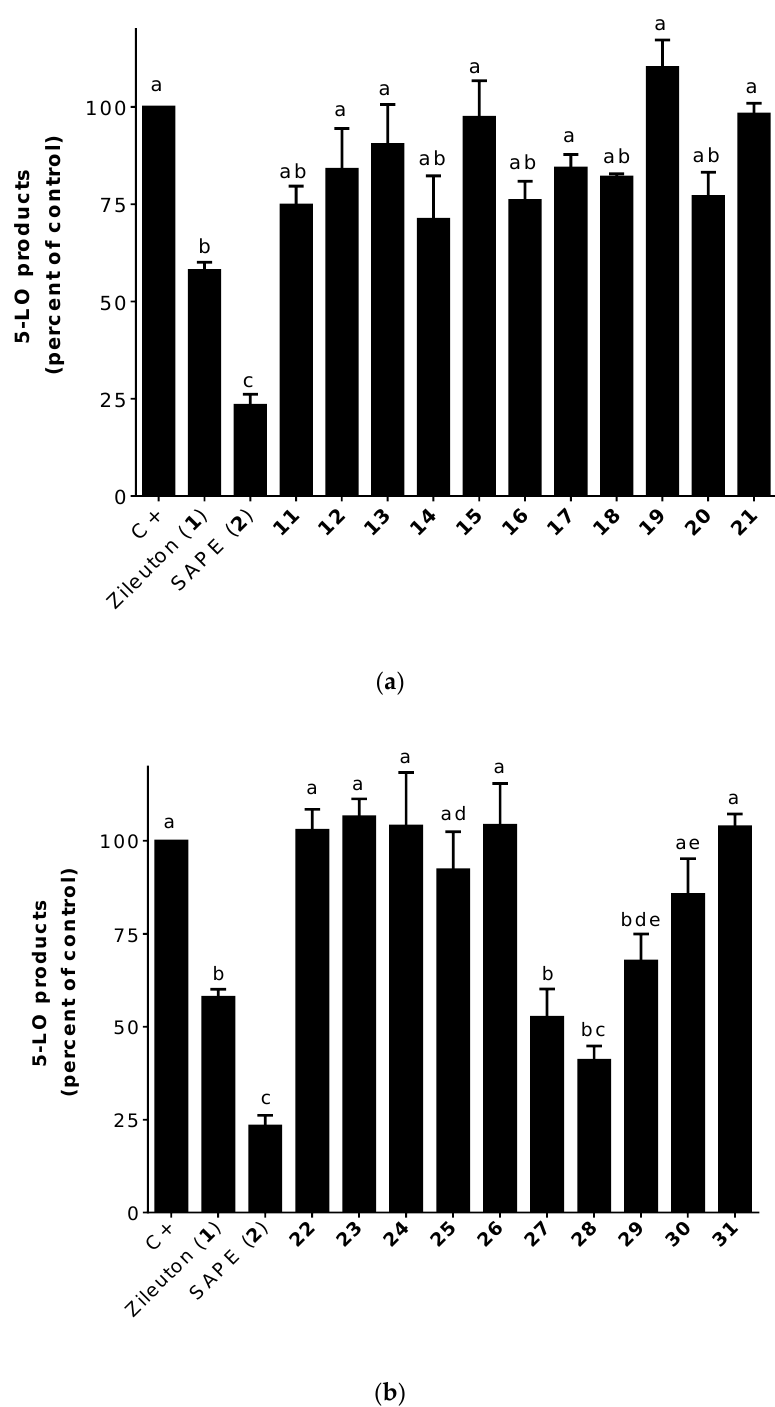
Figure 4. ( a ): Inhibition of the biosynthesis of 5-LO products in stimulated HEK293 cells by zileuton ( 1 ; 1 μM), SAPE ( 2 ; 1 μM), and 11–21 (1 μM). Data are expressed as means ± SEM of at least three independent experiments. Values without one common superscript are significantly different determined by one-way ANOVA with Tukey’s multiple comparison test ( p < 0.05). ( b ): Inhibition of the biosynthesis of 5-LO products in stimulated HEK293 cells by zileuton ( 1 ; 1 μM), SAPE ( 2 ; 1 μM), and 22–31 (1 μM). Data are expressed as means ± SEM of at least three independent experiments. Values without one common superscript (a, b, c, d, or e) are significantly different determined by one-way ANOVA with Tukey’s multiple comparison test ( p < 0.05).